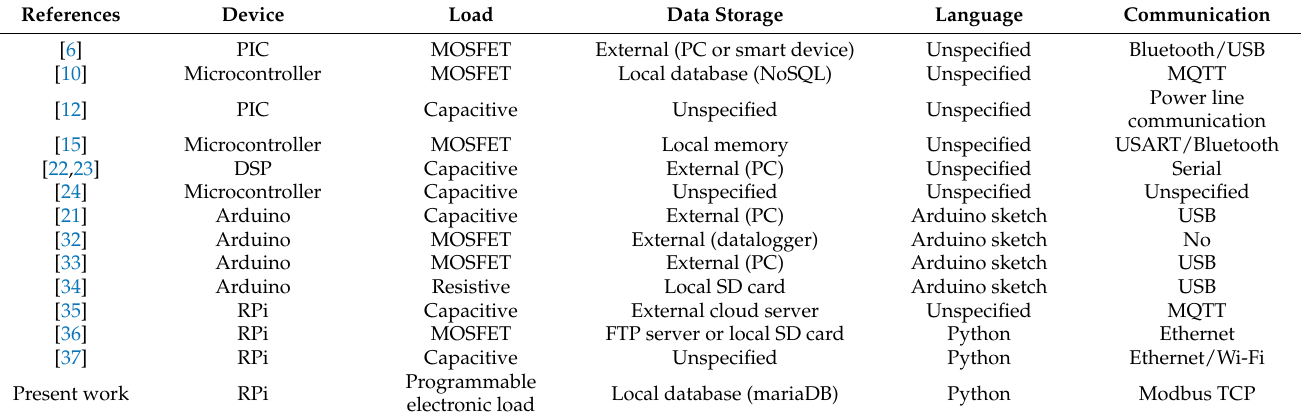
Table 1. Table comparative of previous literature dealing with custom-made curve